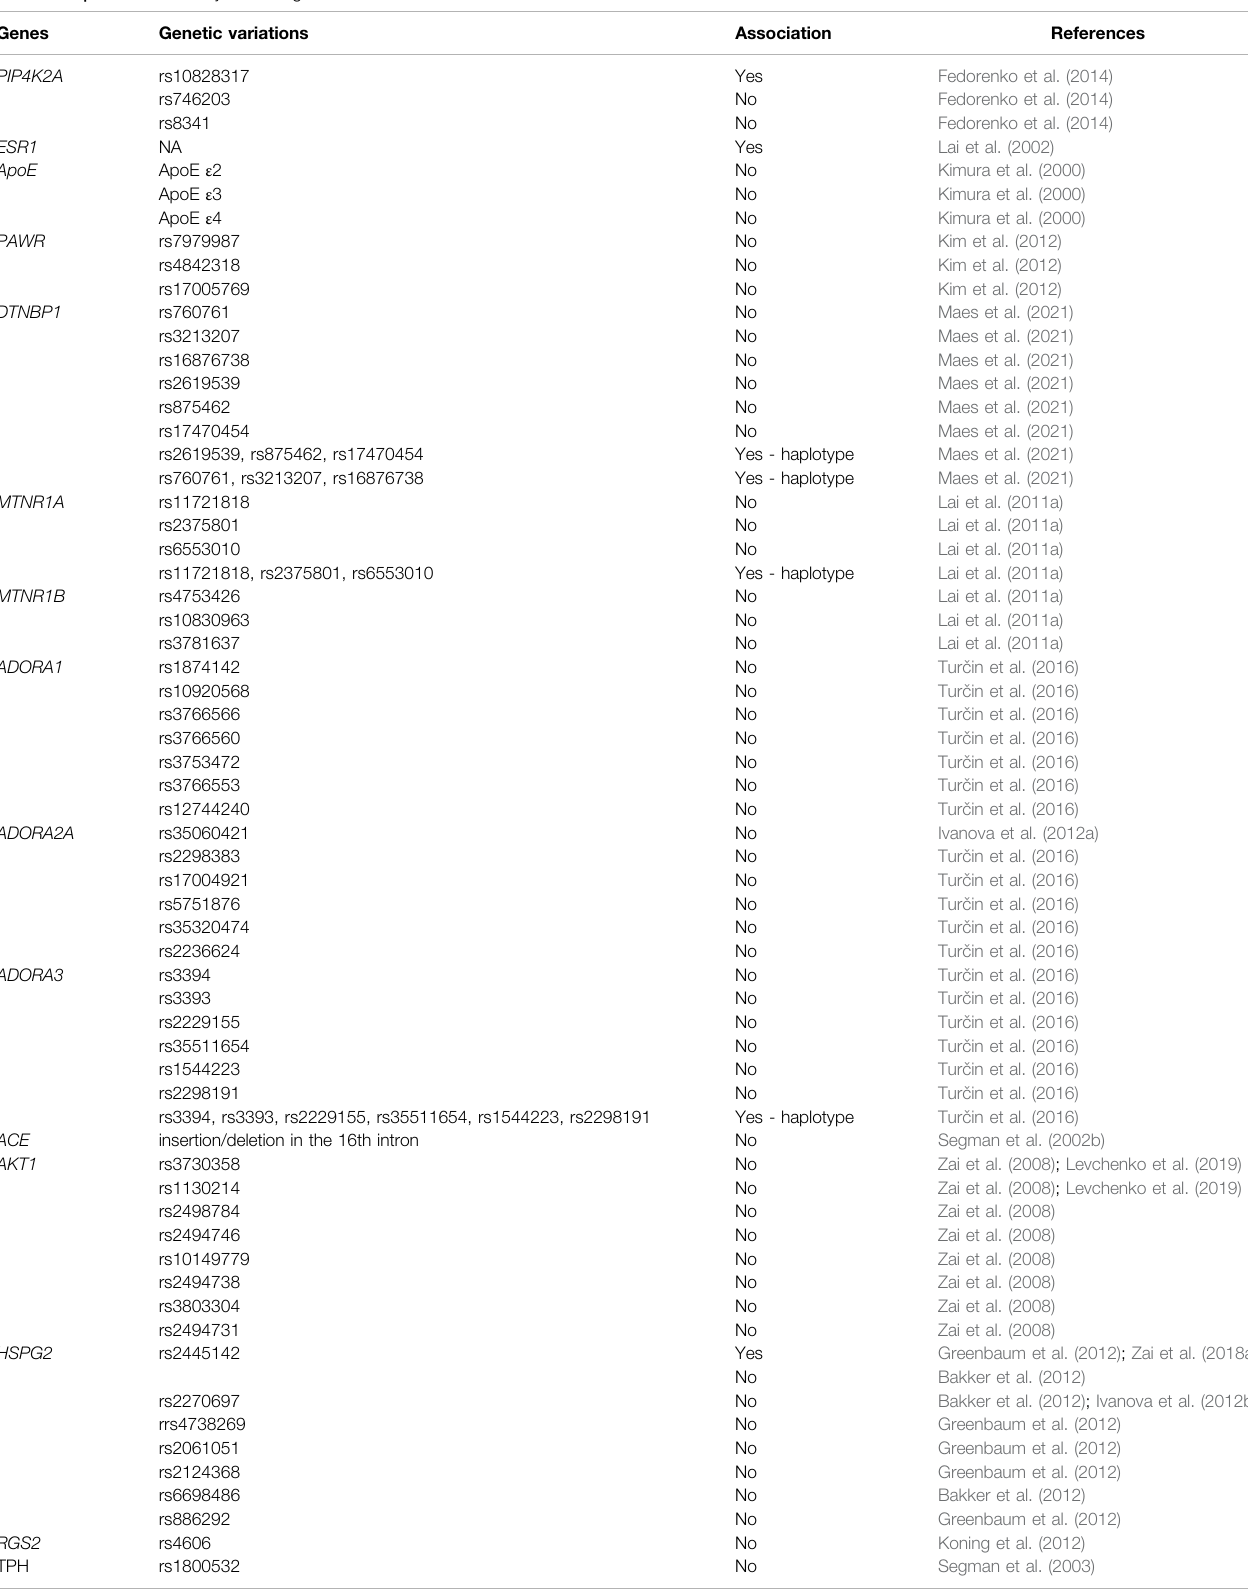
TABLE 10 | Genetic variability of other genes and associations with TD.